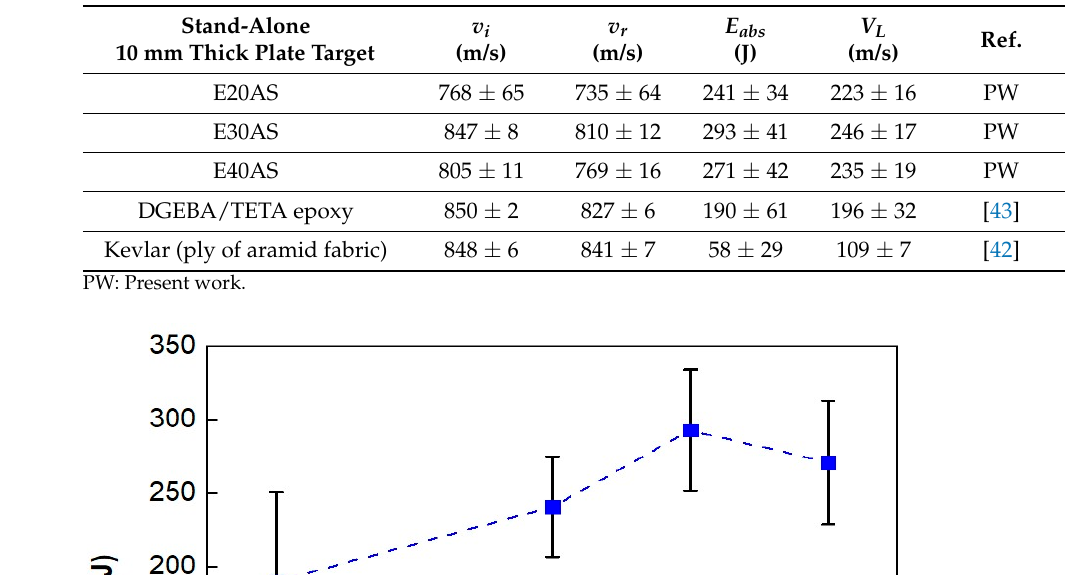
Table 7. Results from 7.62 mm stand-alone ballistic tests for arapaima scales-reinforced epoxy composites compared with results reported for plain epoxy and Kevlar.